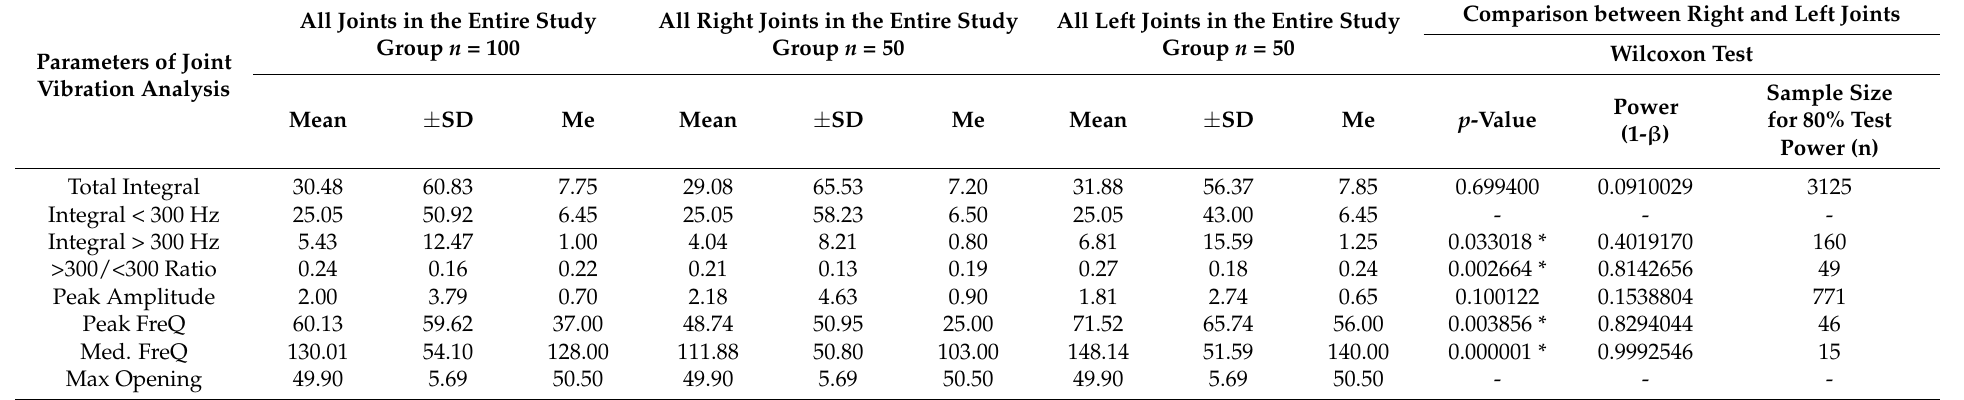
Table 3. Parameters of temporomandibular joint vibration analysis in the entire study group ( n = 50). The mean values, standard deviation ( ± SD), median (Me) and p -value are given.